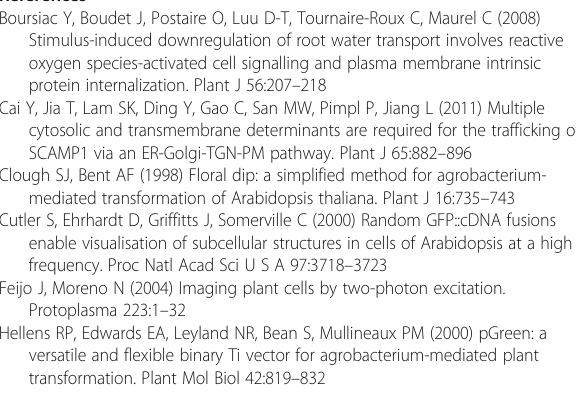
Additional file 1: Figure S1. Subcellular localisation of rice proteins in Arabidopsis root cells. Figure S2. Autofluorescence background in rice primary root cells. Figure S3. Re-localization of rice aquaporins in Arabidopsis root under salt and osmotic stresses. Figure S4. Re-localization of plasma membrane aquaporins in rice primary root under salt and osmotic stresses. Figure S5. Subcellular localization of plasma-membrane protein-marker LTi6a-CFP in rice root under salt and osmotic stresses. (PDF 623 kb) Additional file 2: Table S1. Overview of molecular cloning of membrane protein markers. (DOCX 16